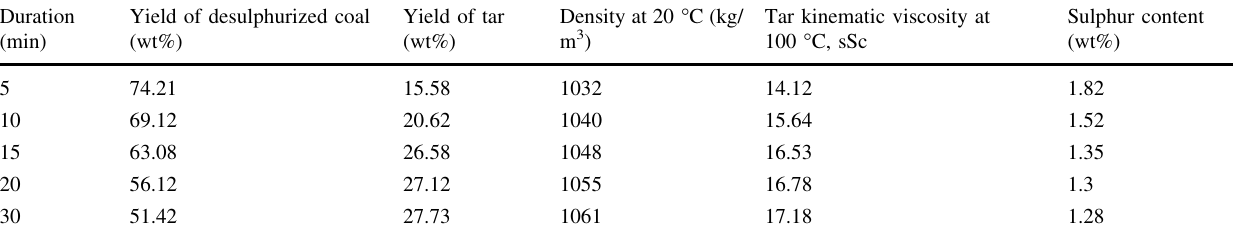
Tar kinematic viscosity at 100 (cid:3) C, sSc